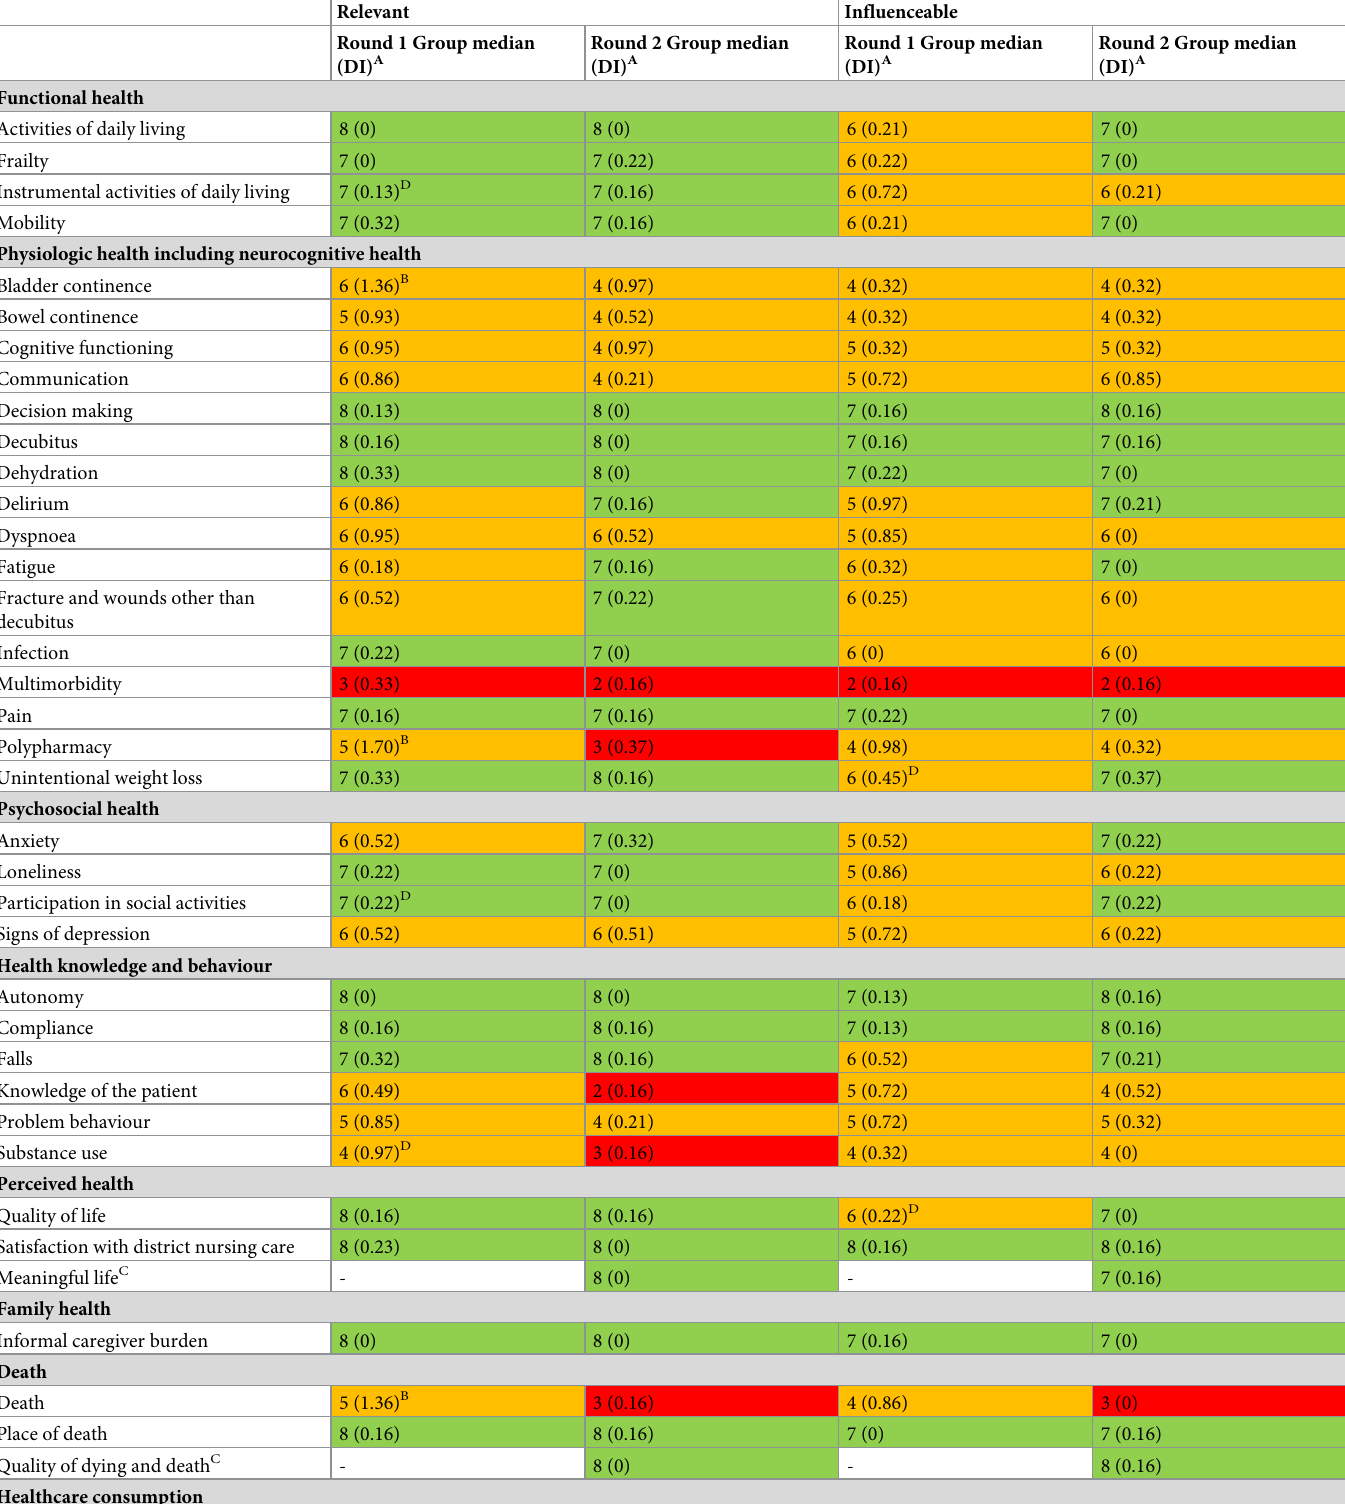
Table 2. Median scores and DIs of the relevance and influenceability of outcomes per Delphi